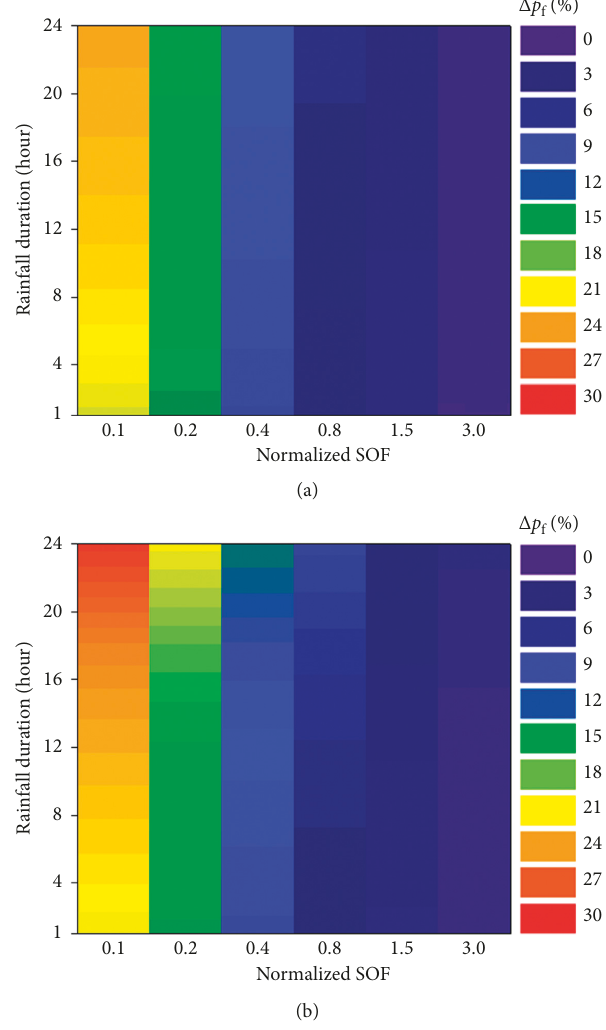
Figure 15: Difference in probability of failure with the results for homogeneous soil ( δ / D � ∞ ) for (a) T r � 2 years and (b) T r � 100